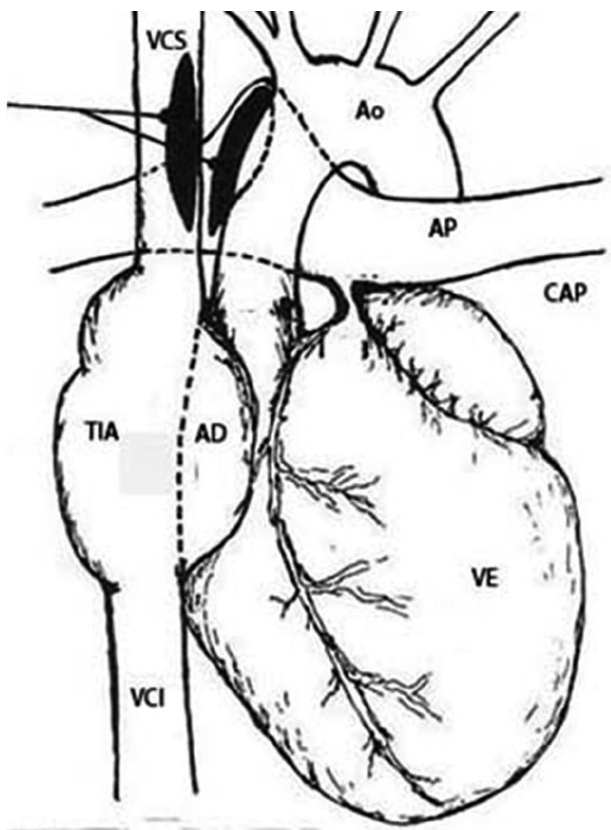
Fig. 1 - Tricuspid atresia and transposition of the great arteries: A side-to-side anastomosis between the medial superior vena cava and the pulmonary artery, previously submitted to cerclage at 21 days of age is performed. An intra-atrial tunnel connects the inferior vena cava to the superior vena cava using bovine pericardium preserved in glutaraldehyde, while using the right atrial wall. VCS = superior vena cava, VCI = inferior vena cava, TIA - intra-atrial tunnel, AD= right atrium, Ao = aorta, CAP = pulmonary artery cerclage, VE = left